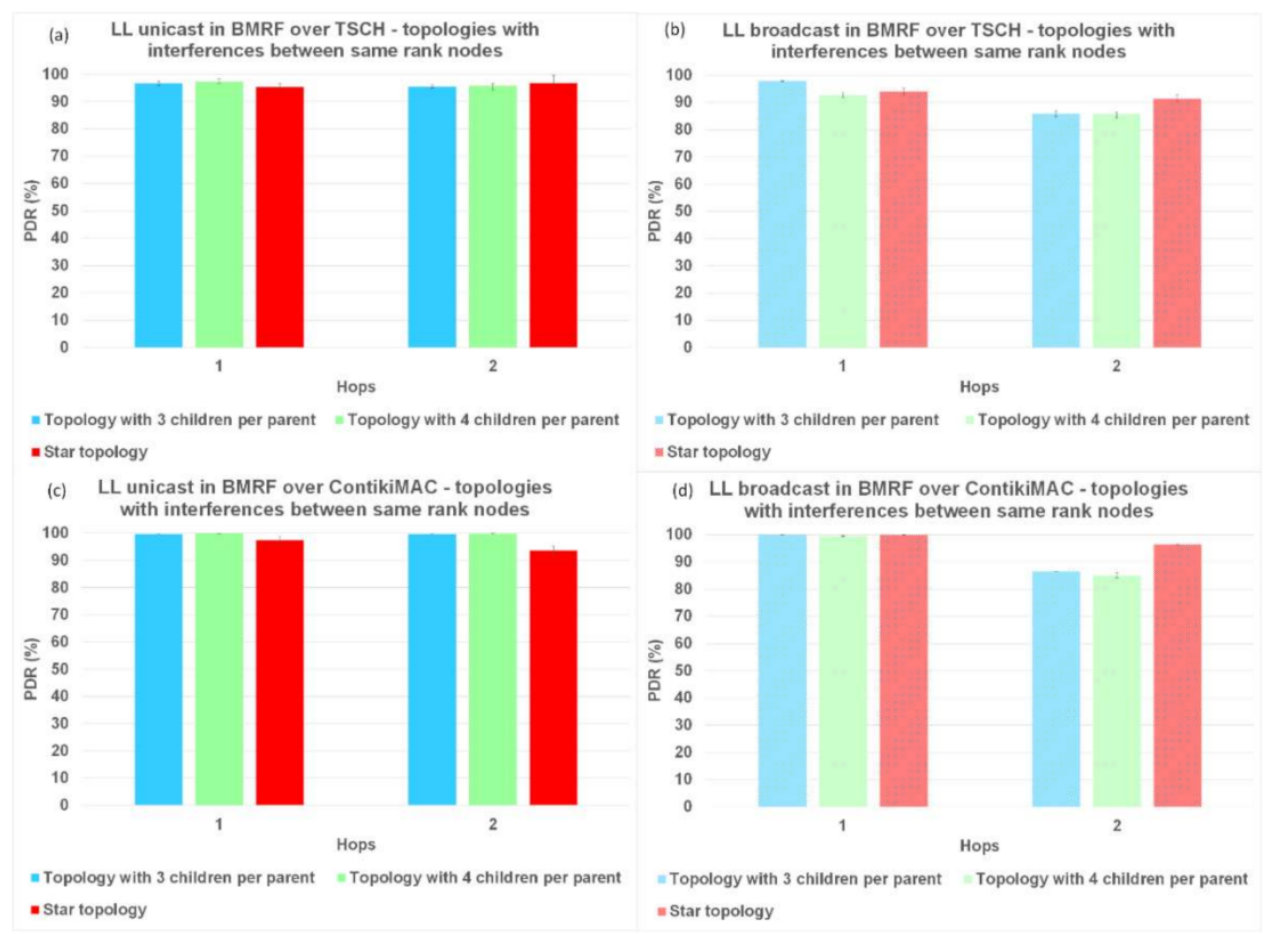
Figure 9. PDR comparison between LL unicast and LL broadcast and between ContikiMAC and TSCH on topologies with interference between same rank nodes. ( a ) Results for LL unicast in BMRF over TSCH. ( b ) Results for LL broadcast in BMRF over TSCH. ( c ) Results for LL unicast in BMRF over ContikiMAC. ( d ) Results for LL broadcast in BMRF over